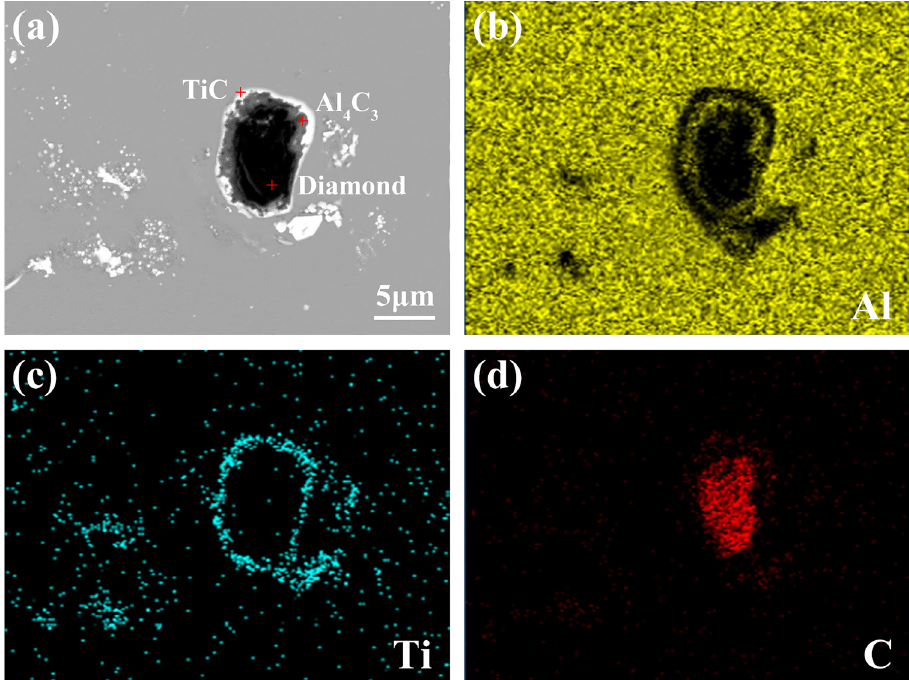
Figure 11. EDS mapping analysis of core–shell particles in Al-4Ti-1D (10 μ m): ( a ) microstructure and ( b – d ) mapping micrographs for Al, Ti, and C elements.